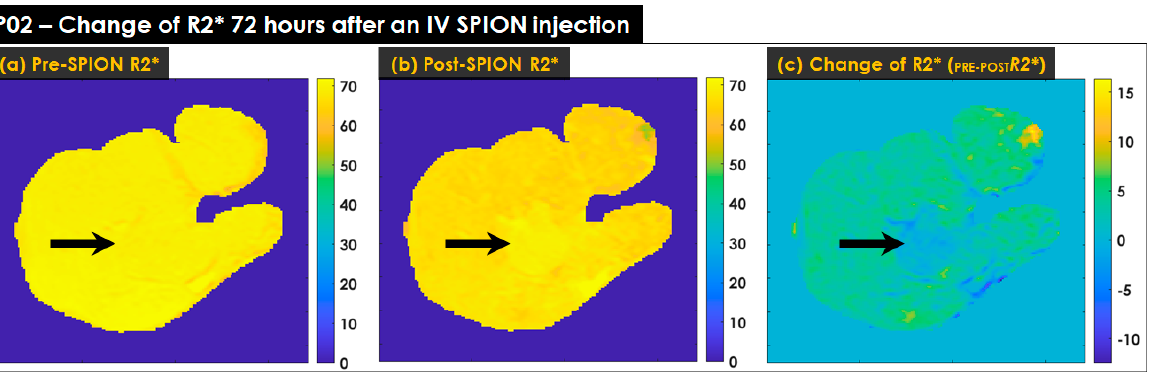
Figure 5. The change in R2* measured in patient P02 before and 72 h after an IV SPION injection. ( a ) The R2* (TE = 13.8 ms) of pre-SPION; ( b ) the R2* (TE = 13.8 ms) of post-SPION, and ( c ) the change in R2* calculated by subtracting ( a ) to ( b ). The black arrows point to the tumor in each panel. In ( a ), pre-SPION R2*, there is no visual difference between tumor and liver tissue. The tumor is visually lighter in ( b ), post-SPION R2*, and darker in ( c ) compared to surrounding tissues. The change in R2* was minimal on the tumor but considerable for FLP in PRE-POST R2* , as shown by the coloration of FLP but not the tumor in ( c ).